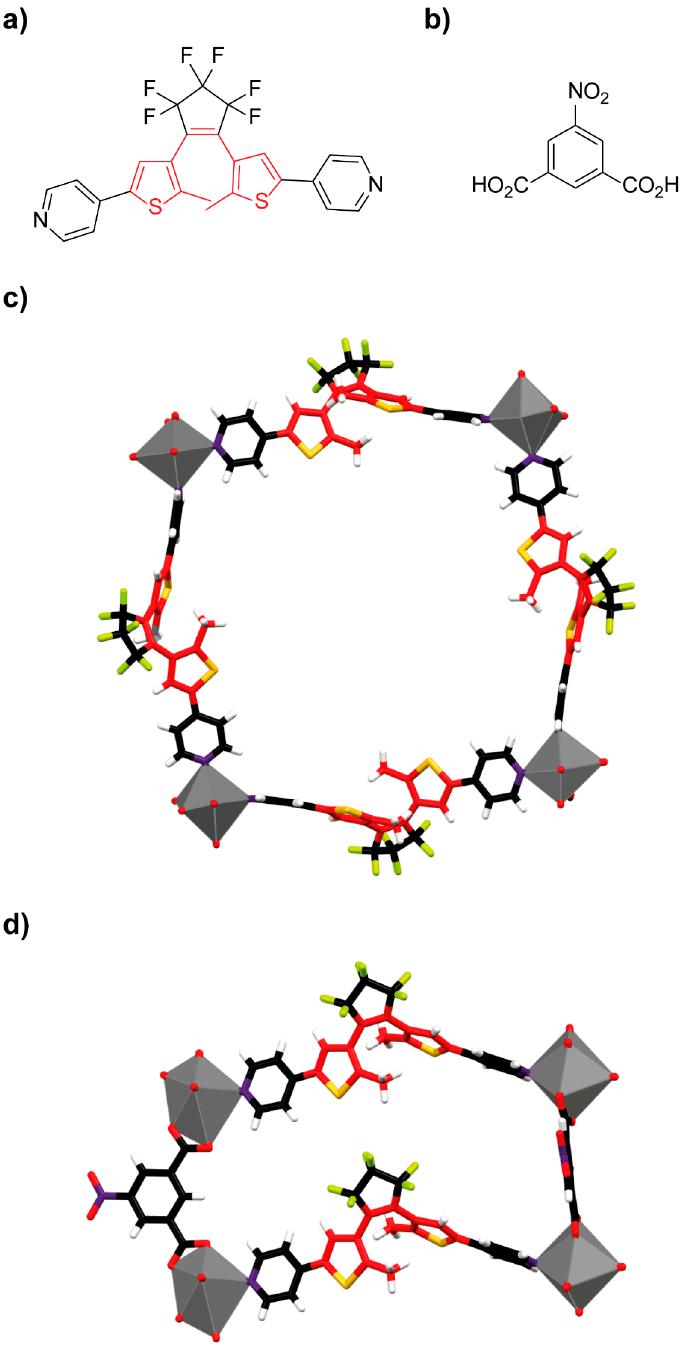
Figure 6. ( a ) Chemical structure of the diarylethene linker 3 ; ( b ) structure of nip 2 − ; ( c ) stick represen- tation of the crystal structure showing the square-shaped macrocycles structure of the diarylethene- based DTE MOF ; ( d ) stick representation of the crystal structure of DTE MOF showing the connections between one side of two different macrocycle-shaped diarylethene-containing metallogrids [68]. Interpenetration is omitted for clarity in the solid structure. Color key: grey = cadmium atoms; black = carbon atoms; red = oxygen atoms and carbon atoms of the diarylethene motif; white = hydrogen atoms; yellow = sulfur atoms; green = fluor atoms; purple = nitrogen atoms.